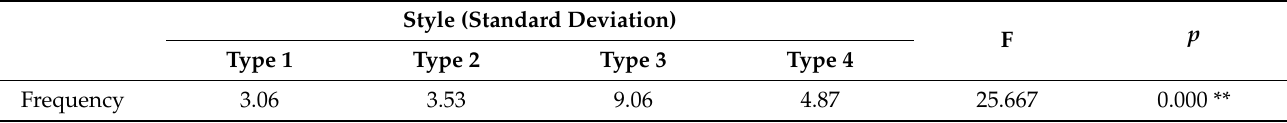
Table 8. Homogeneous variance analysis of key-style saccades.